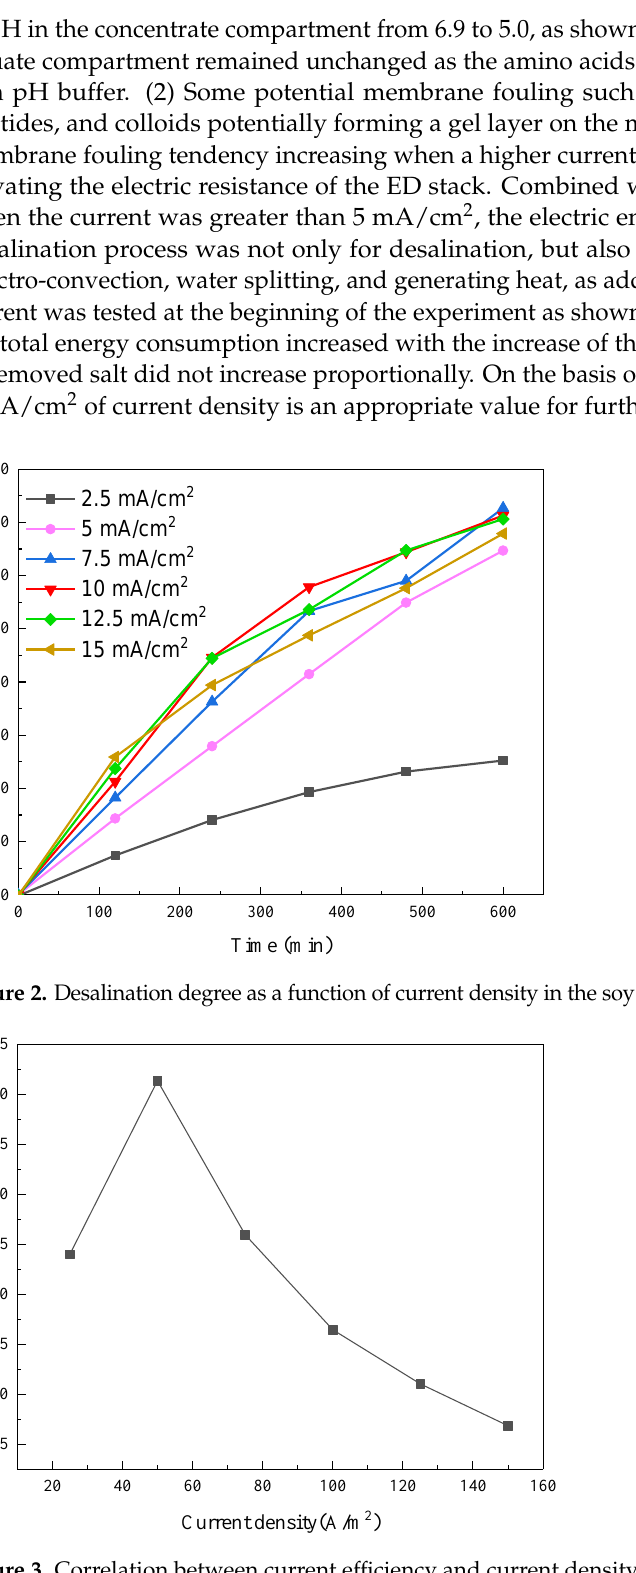
Figure 3. Correlation between current efficiency and current density for the soy sauce desalination process.